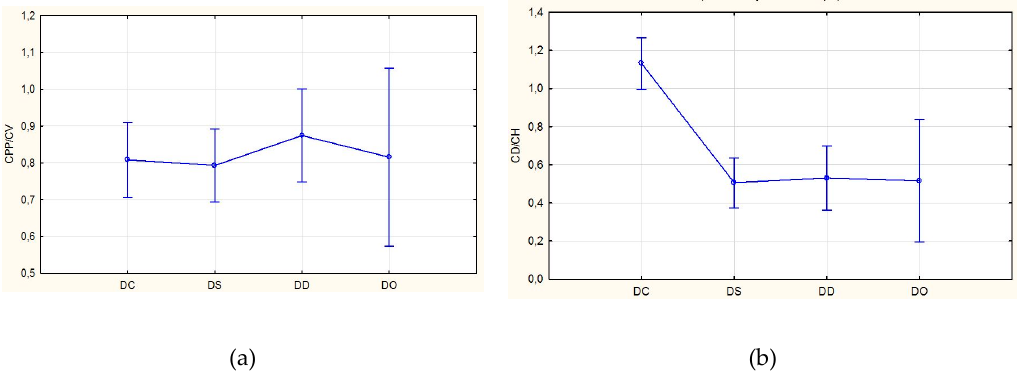
Figure 8. (a) Canopy volume coefficient (CVC) computed as the ratio of canopy planar projection to canopy volume (CPP/CV). ( b) Canopy height coefficient (CHC) computed as the ratio of canopy depth to canopy height (CD/CH). Key: DC—Dracaena cinnabari; DS—D. serrulata; DD—D. draco; DO— D. ombet.